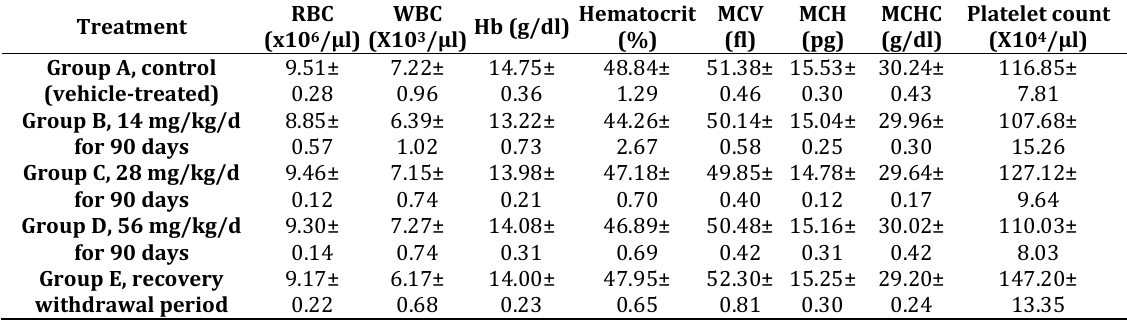
RBC WBC Hematocrit Hb (g/dl) (x10 6 /µl) (X10 3 /µl) (%)